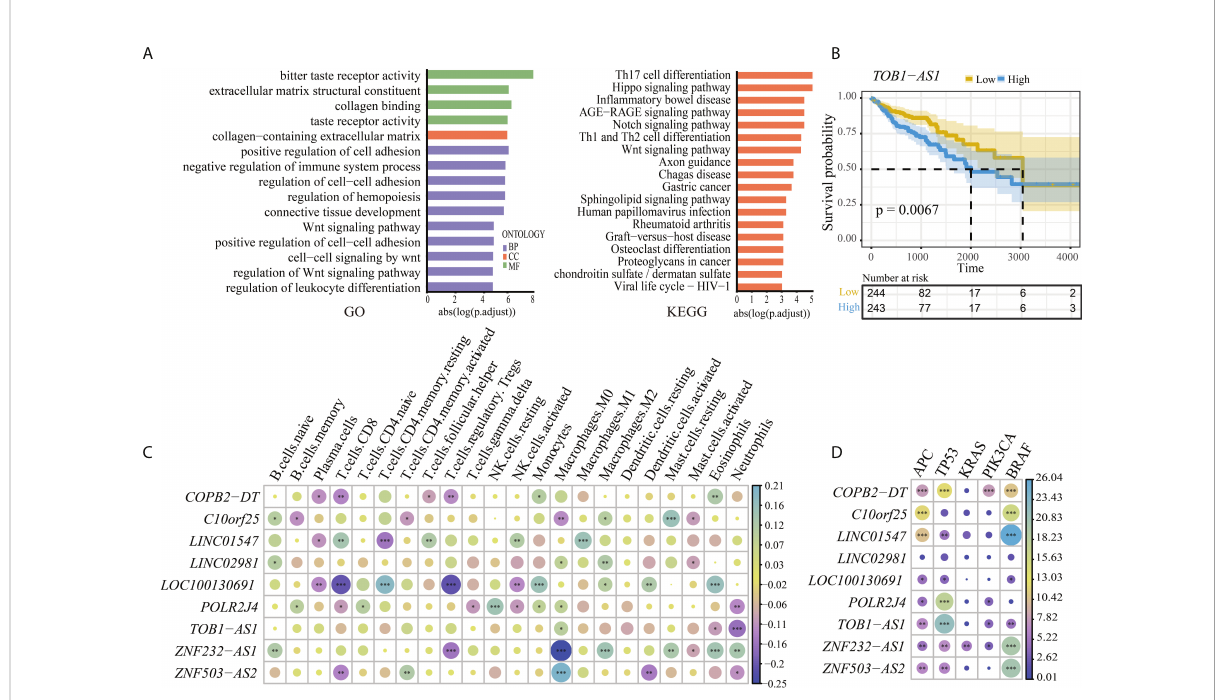
FIGURE 3 (A) The pathway enrichment analysis of the lncRNA biomarkers. Left is the result of Gene Ontology (GO); right is the result of KEGG. (B) High expression of lncRNA TOB1-AS1 was associated with a worse prognosis outcome in CRC. (C) Association between the immune cell in fi ltration and the lncRNA biomarkers. *, **, and *** represent the P-values of 0.05, 0.01, and 0.001, respectively. The size of the circle represents the correlation coef fi cient. (D) The correlation of expression of lncRNA markers and driver genes in CRC. *, **, and *** represent the P-values of 0.05, 0.01, and 0.001, respectively. The size of the circle represents the size of the absolute value of log10